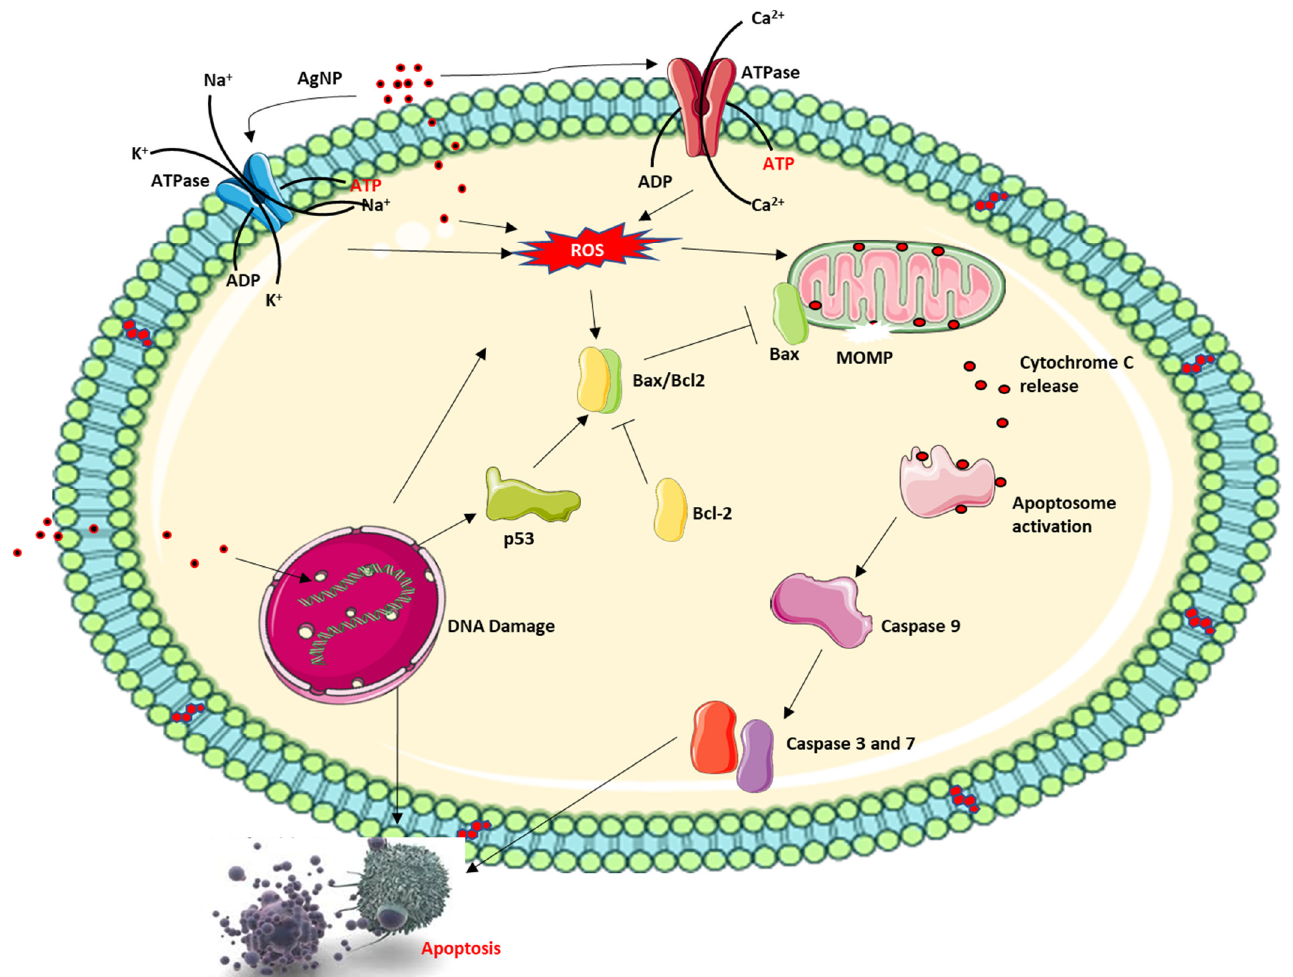
Figure 4. Proposed mechanism of action of AgNPs.